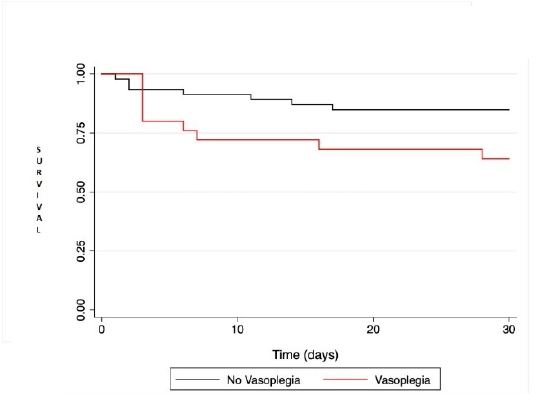
Figure 1. Kaplan-Meier survival analysis comparing patient survival at 30 days after heart transplan- tation or left ventricular assist device. Comparison between the two groups was performed with the log rank test and was not statistically significant ( p = 0.051). Table 3. Postoperative adverse events according to the presence of VS.